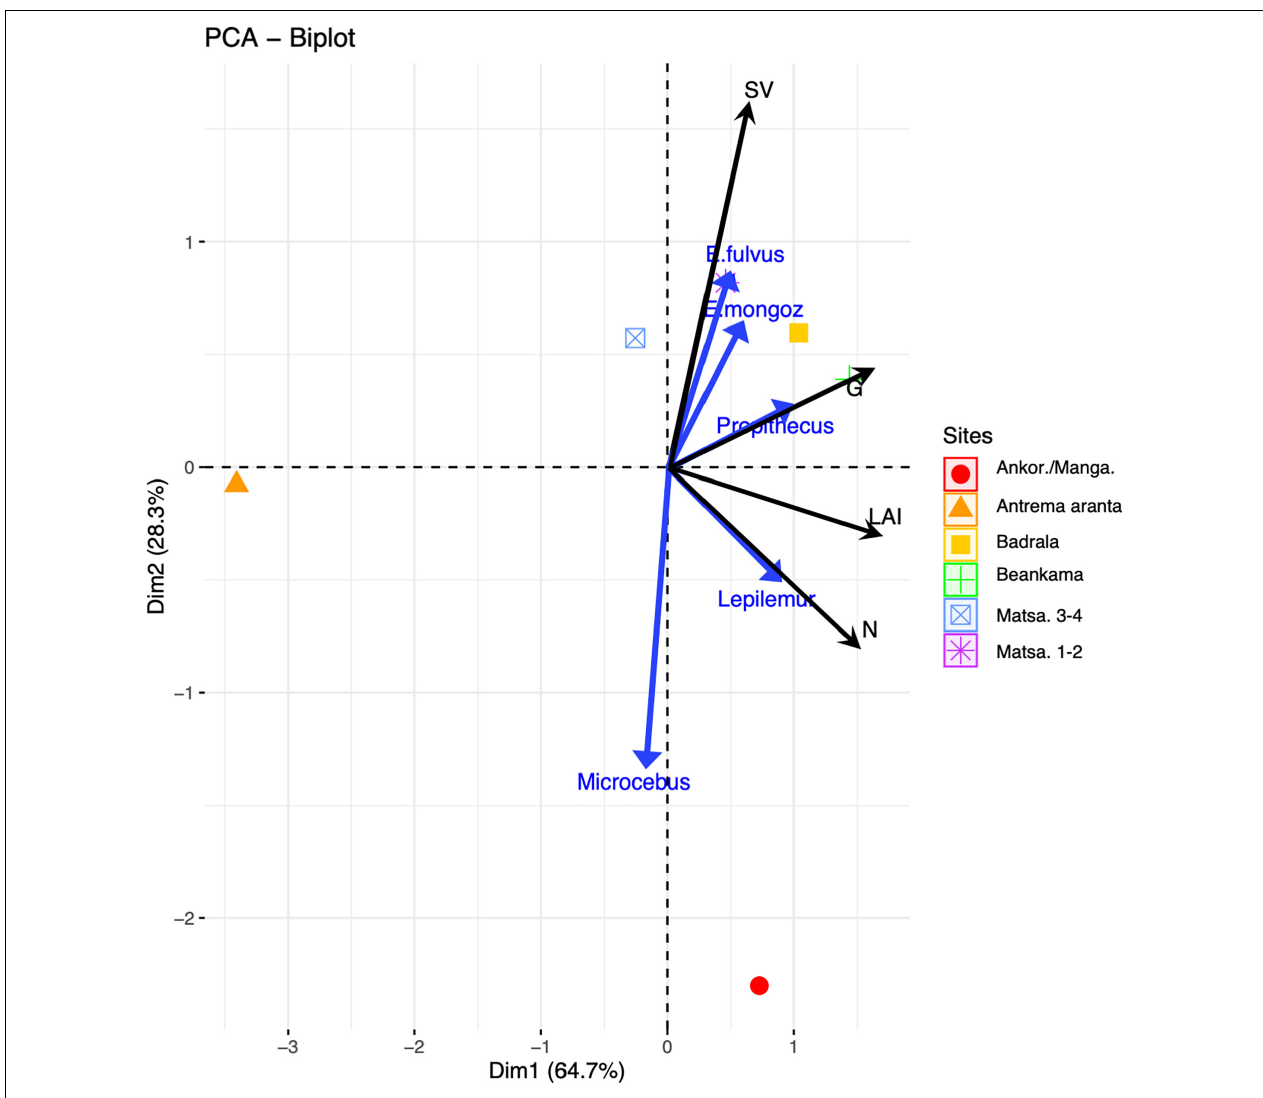
FIGURE 3 | Principal components of forest characteristics (6 sites), with lemur densities as supplementary variables (blue arrows). N, number of trees ≥ 10 cm dbh per ha; G, total basal area per ha; SV, Shannon-Wiener index; LAI, leaf area index. Forest sites follow the same code as in Table 1 (note that Antrema doany, i.e., the Prince’s area of residence, was not included in this analysis; see Text). Dimension 1 loads positively on LAI, N, and G. Dimension 2 loads positively on